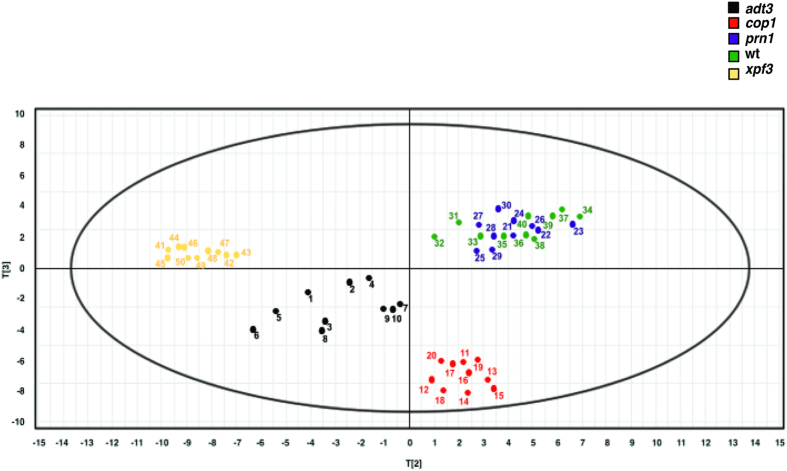
Principal component analysis (PCA) of A. thaliana mutants and wt indicate both batch-to-batch consistency and distinct clustering of mutants.Principal component analysis (PCA) of the mutants xpf3, prn1, adt3, cop1 and wt samples, using relative content of peaks from UV spectroscopy (under UV254 nm, UV280 nm and UV320 nm) as variables, demonstates that the samples formed their own cluster within a small region significantly separate from each other, with the exception of the prn1 and wt samples. Data graphed in two dimensions using the software SIMCA-P 11.0., n = 10 batches, with each point on the graph representing a batch of the plant mutant or wt grown. The spread of the cluster corresponds to the batch to batch variability.